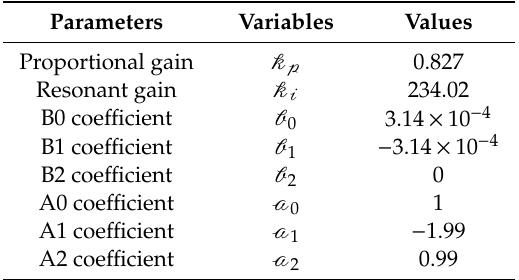
Table 6. Designed digital Proportional-Resonant (PR) controller